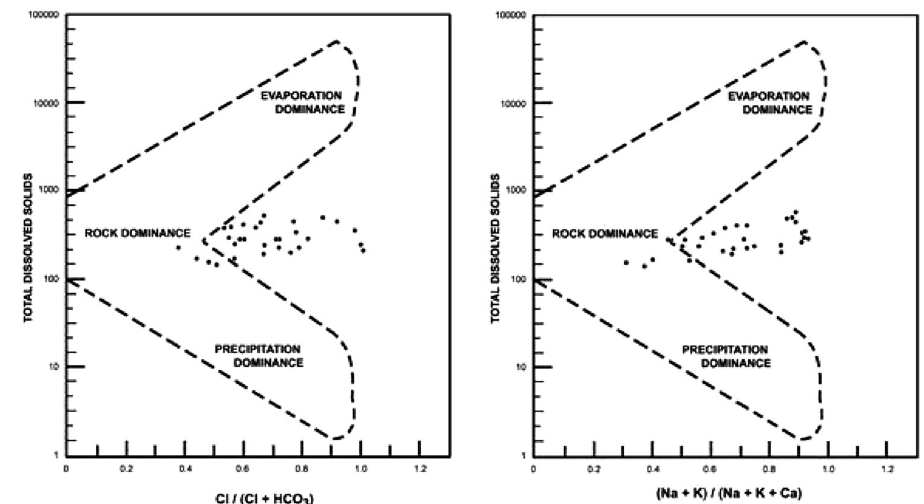
Fig. 4 Gibbs diagrams for hydro-chemical quality of groundwater resources of the study area (after Gibbs